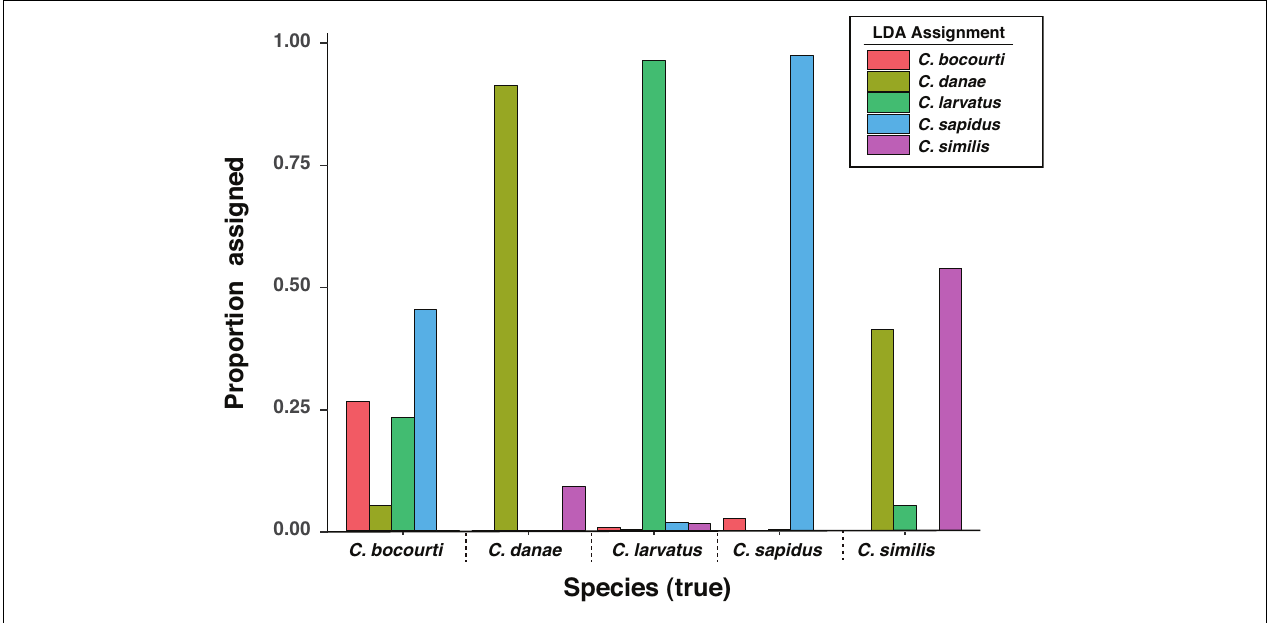
FIGURE 7 | Linear discriminant analysis (LDA) assignment rates for HRM difference curve data across known species. Assignment data are the result of LDA classifications for 100 resampling events of the data set split randomly and equally into training and validation